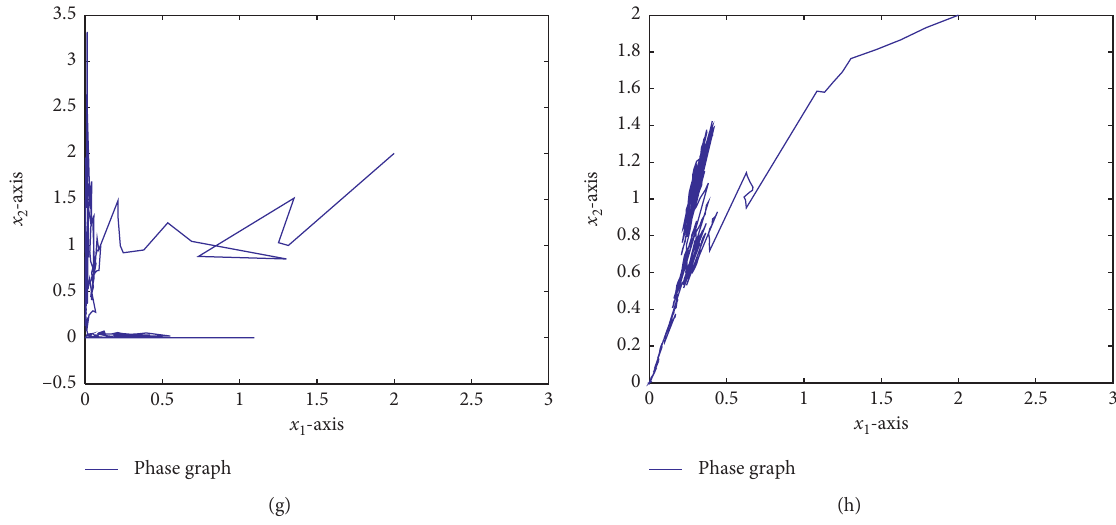
( t ) , (b) the time series graph 1